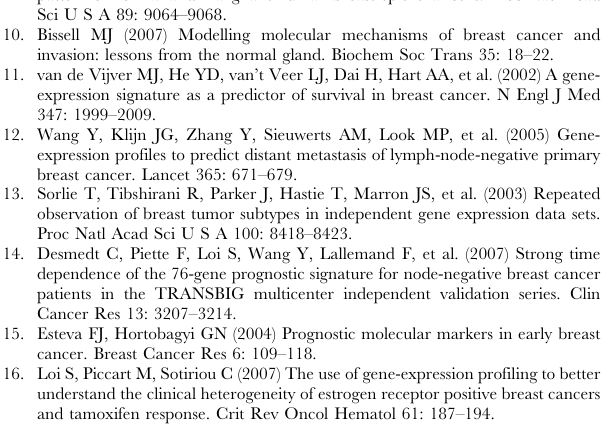
Table S2 Comparison of microarray datasets